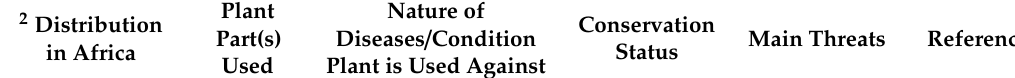
Table 1. Hypoxis species diversity in Africa (adapted from African Plant Database [4]).